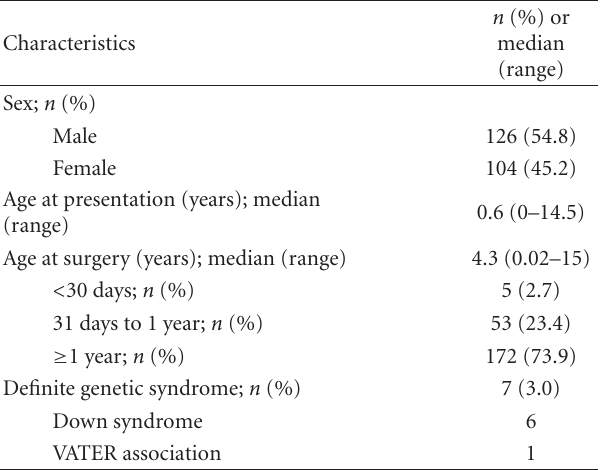
Figure 2: Mortality rate by RACHS-1 in the present study ( n = 230). Table 1: Patients’ baseline characteristics in the present study ( n = 230).